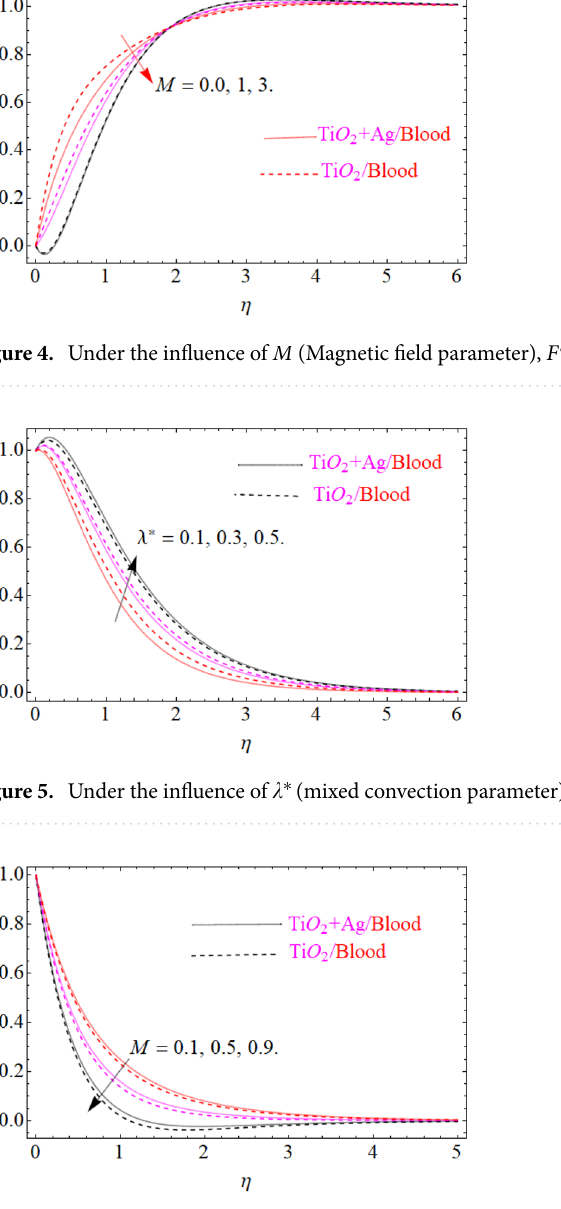
Figure 6. Under the influence of M (Magnetic parameter), G (η) .